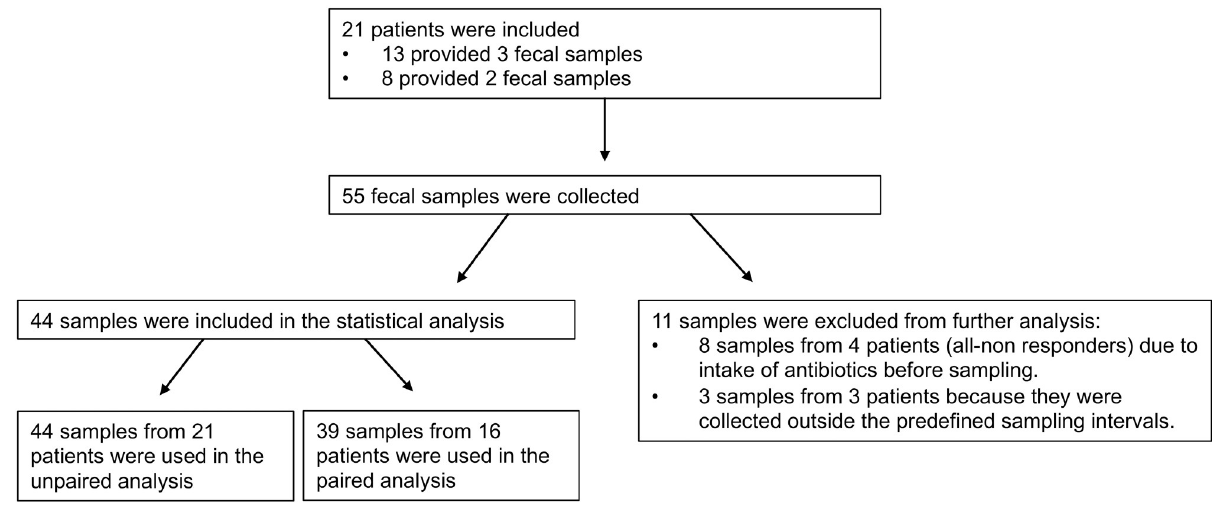
Fig 1. Flow chart of included patients and samples used in the statistical analysis.